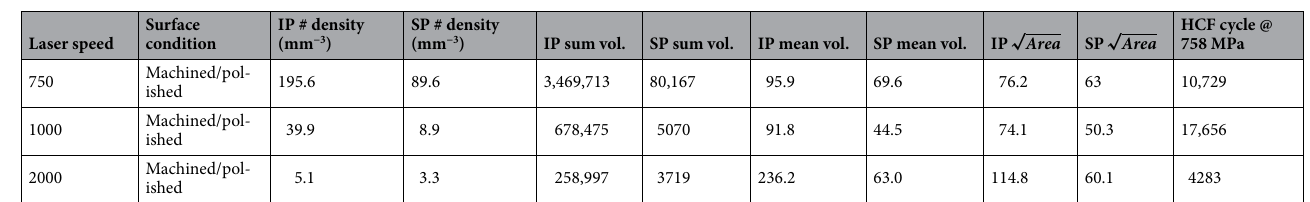
√ Area in µm unit.